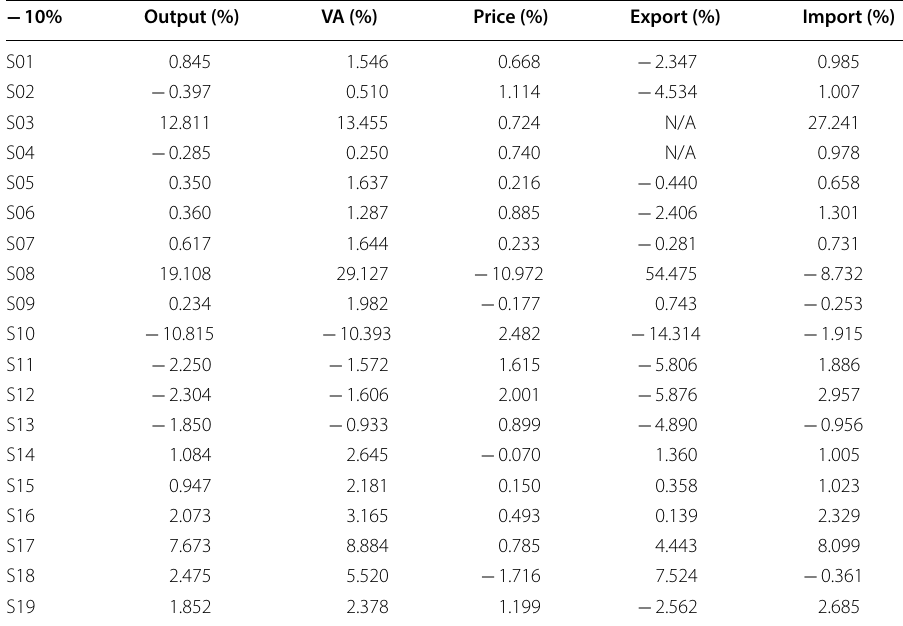
Table 4 The effects of a 10% decrease in crude oil domestic prices